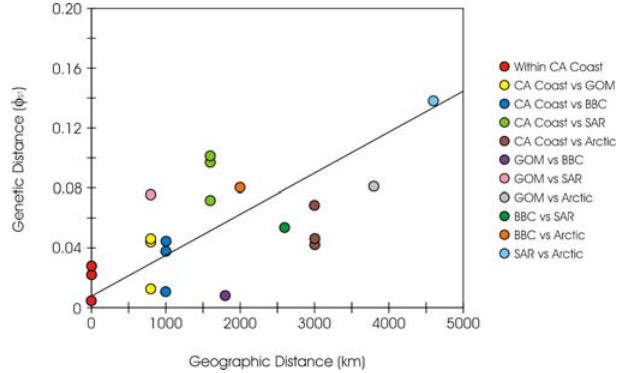
Figure 5. Relationship between Geographic and Genetic Distances of Marine Viral Assemblages In addition to the four metagenomes sequenced for this study, the previous viral metagenomes from the San Diego area (California coast) were also included in this analysis [10]. There was a significant correlation of 3.28 3 10 (cid:1) 5 U ST / km (Mantel test, Z ¼ (cid:1) 78.9, p , 0.017, r ¼ 0.585). DOI: 10.1371/journal.pbio.0040368.g005